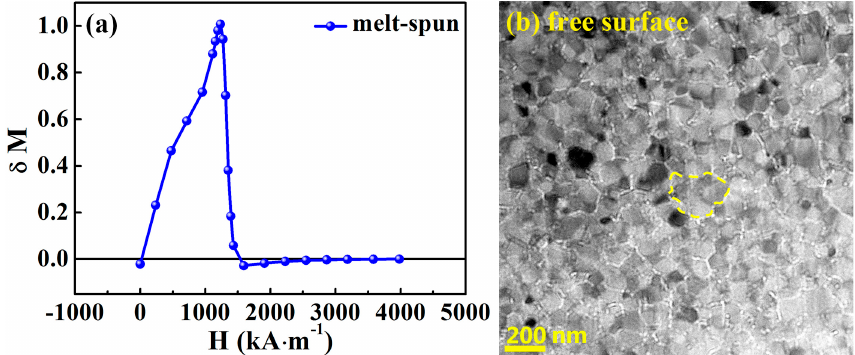
interaction between 2:14:1 grains. Figure 5b shows the Lorentz microscopy image of the cross-sectional region near the free surface of melt-spun ribbon. This was observed in the Fresnel mode. The size of the domain (marked as yellow dashed line) is about 290 nm, which is close to the critical size for single-domain particles ( ᾂ ≈ 300 nm for Nd 2 Fe 14 B [29]). It is much larger than the average grain size of 64 nm. That is, a domain includes several grains. Such a domain is also termed an interaction domain due to magnetic coupling between neighboring grains [30]. It indicates that the hard magnetic 2:14:1 grains have an exchange coupling interaction through the ferromagnetic GB phase.